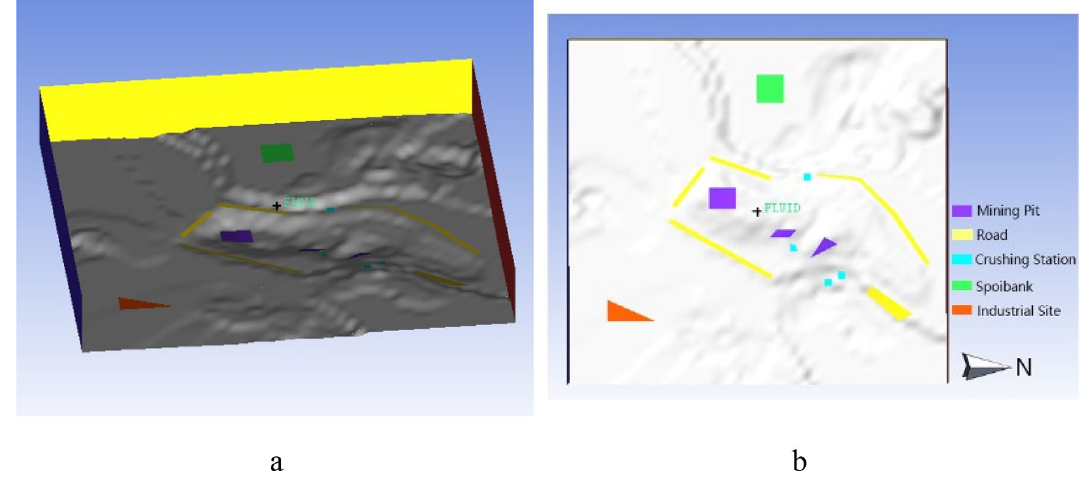
Figure 1. 3D modeling diagram of mining